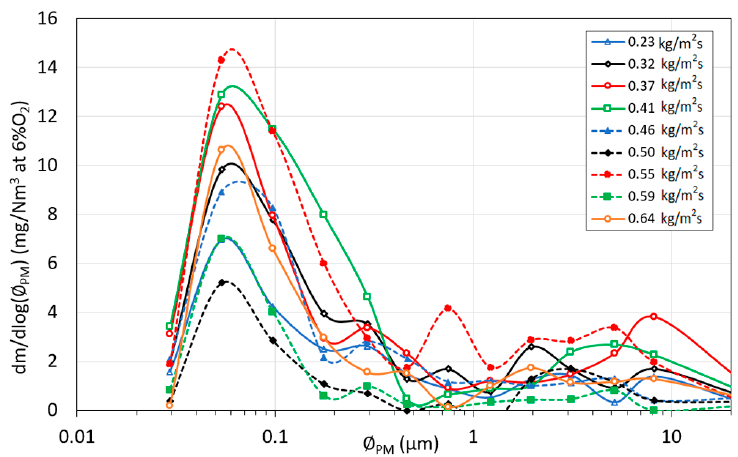
Figure 12. PM size distribution function for φ = 20% but different total airflow rates and wp2.